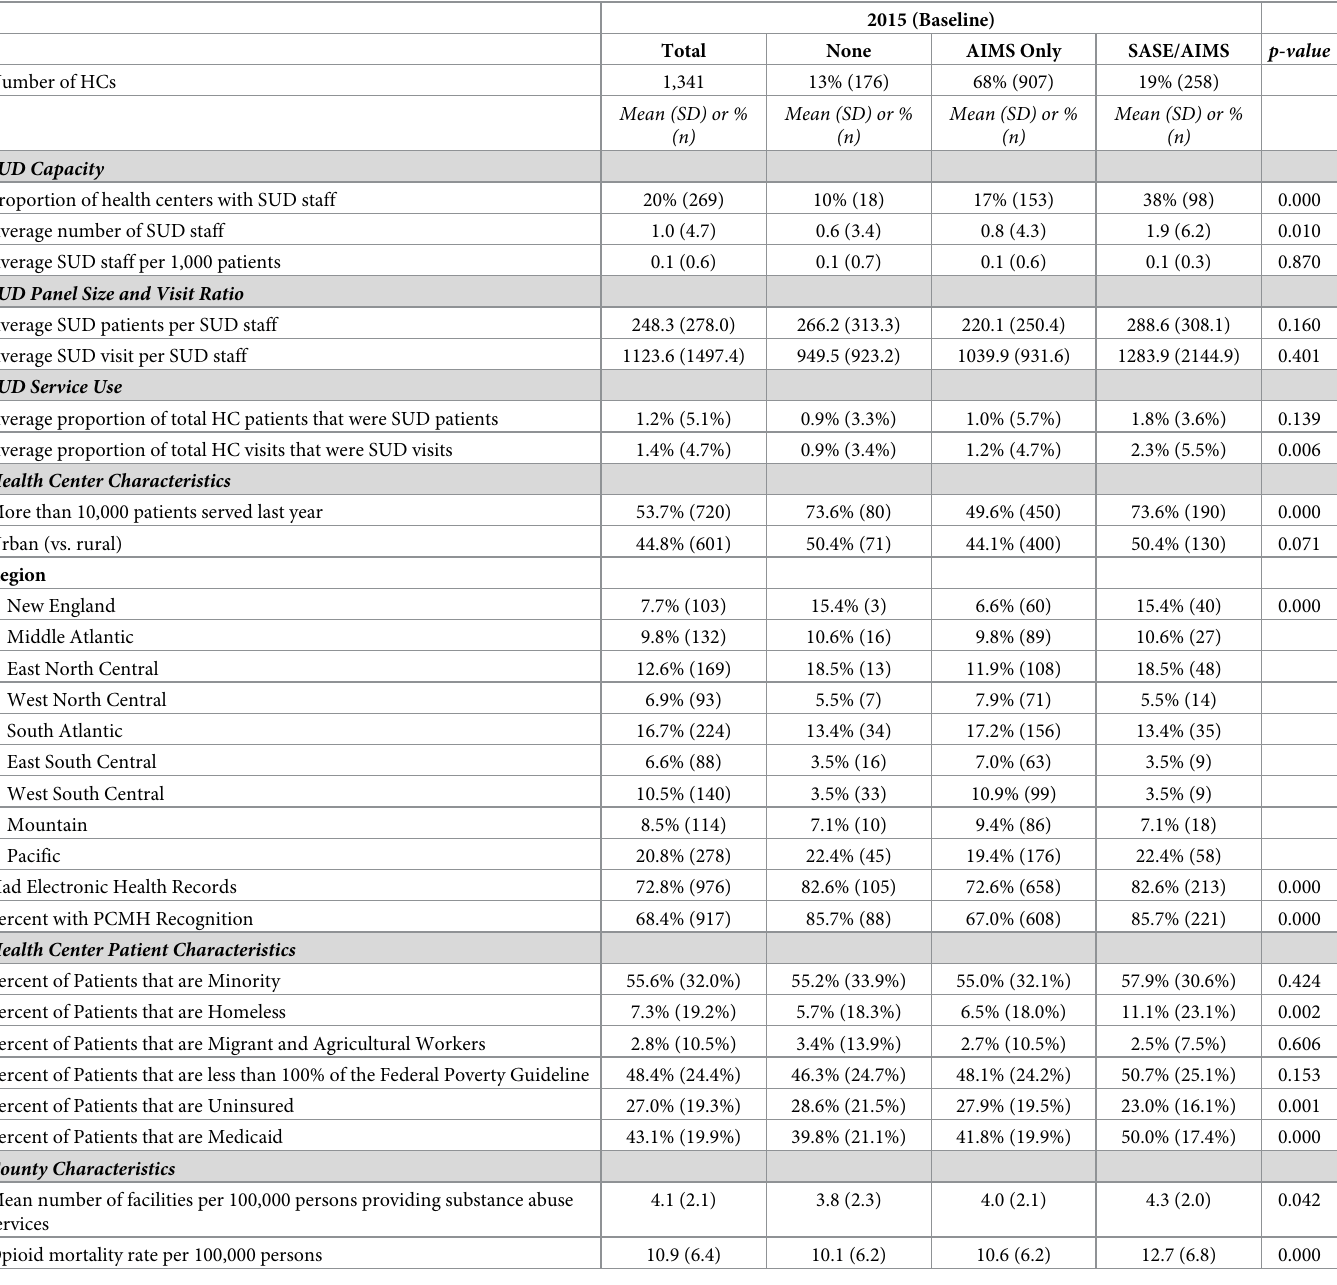
Table 2. Health center characteristics by SASE and AIMS grantee status in